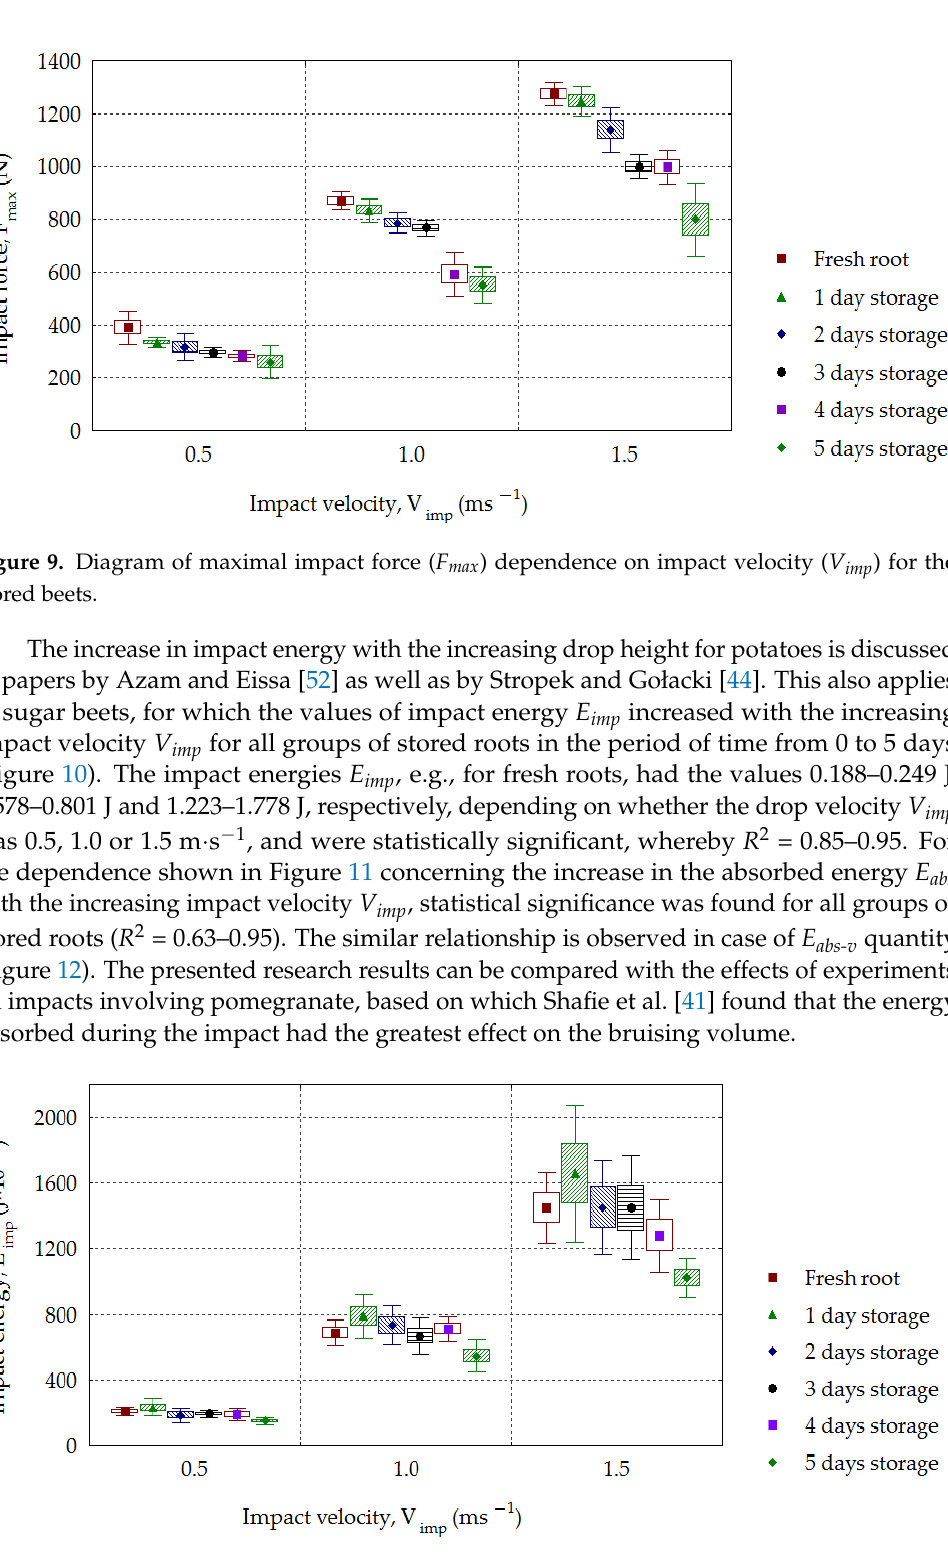
Figure 10. Dependence of impact energy ( E imp ) on the impact velocity ( V imp ) for the stored beets.